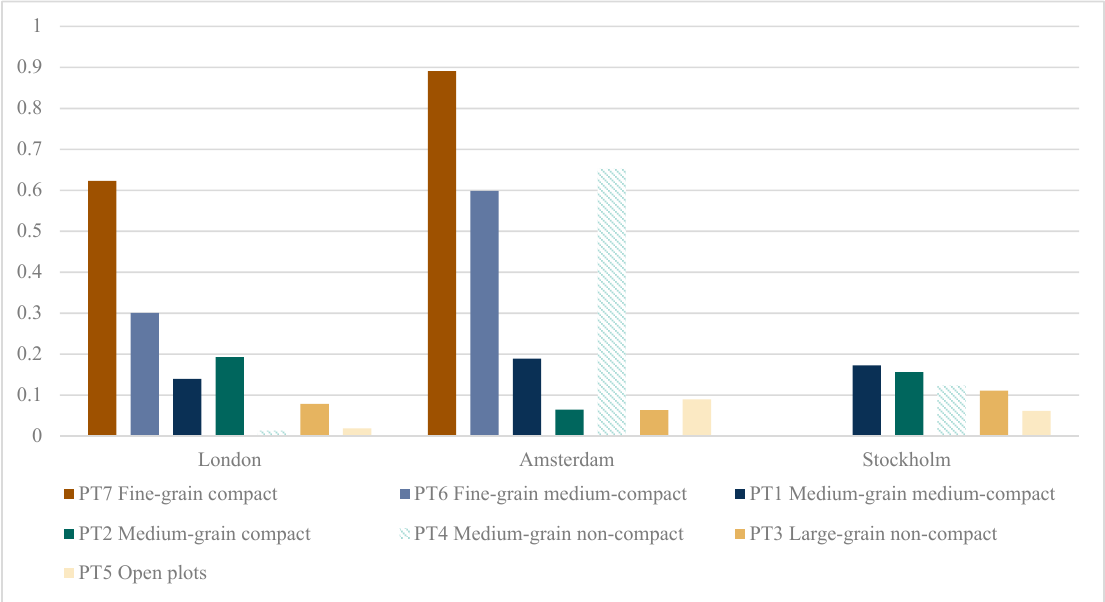
Figure A7. Summary of statistical analysis of di ff erences between the plot types in terms of the dependent variable distribution. Bar charts show median values for each sub-model. If a particular plot type covers less than 5% of observations within the sub-model, it is shown as a dashed bar.